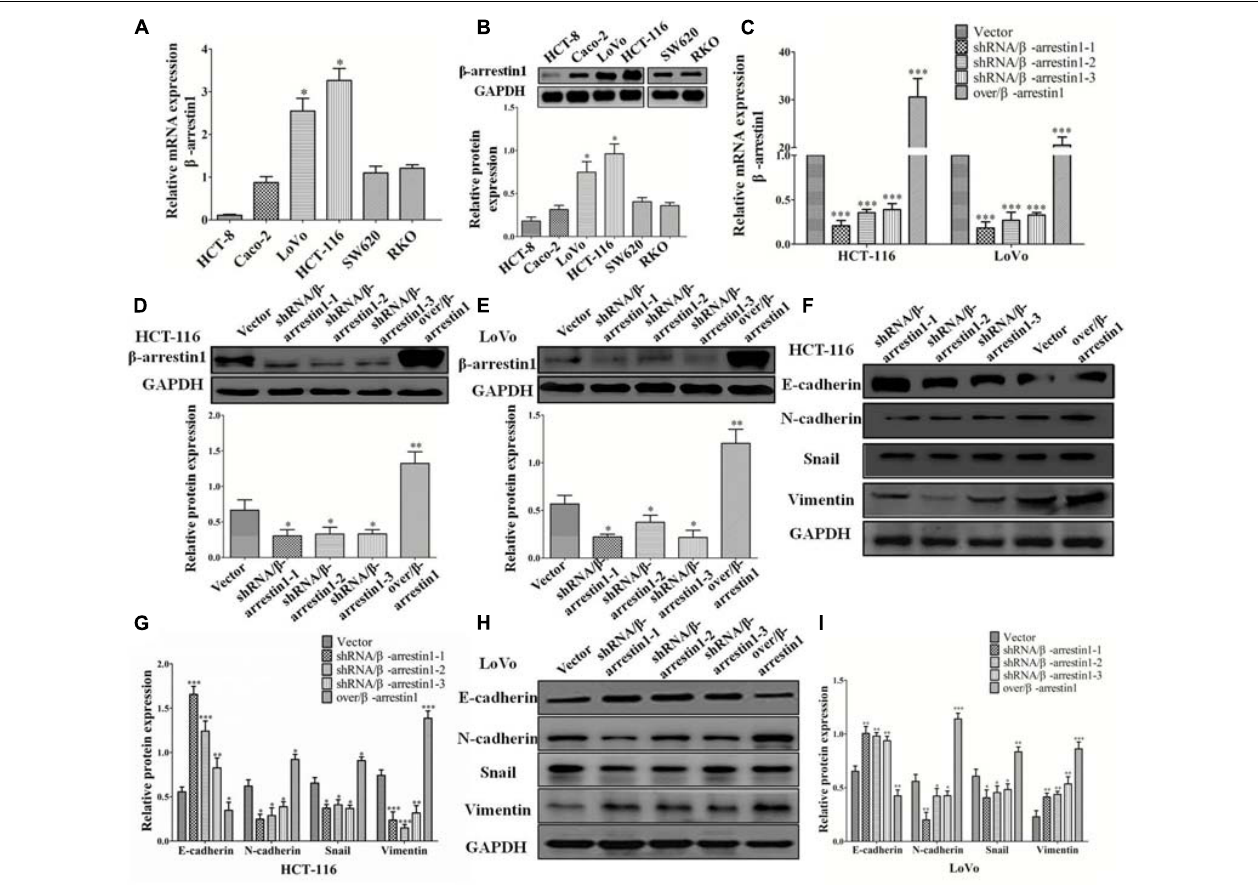
FIGURE 2 | β -arrestin1 regulates the EMT of CRC cells. (A,B) The expression of β -arrestin1 was detected in six CRC cell lines by reverse transcription quantitative PCR. β -arrestin1 had a higher expression level in LoVo and HCT-116 cells, ∗ P < 0.05 vs. the other four established human CRC cell lines HCT-8, Caco-2, SW620 and RKO. (C) The mRNA expression of β -arrestin1 in shRNA/ β -arrestin1 and over/ β -arrestin1 groups was detected by reverse transcription PCR. ∗ P < 0.05; ∗∗ P < 0.01 vs. HCT-116-vector or LoVo-vector cells. (D–E) Western blotting detected the protein expression of β -arrestin1 in shRNA/ β -arrestin1 and over/ β -arrestin1 groups in HCT-116 or LoVo cells. ∗∗∗ P < 0.001 vs. HCT-116-vector or LoVo-vector cells. (F–I) Expression levels of epithelial or mesenchymal markers in HCT-116 or LoVo cells were analyzed by western blotting. ∗ P < 0.05; ∗∗ P < 0.01; ∗∗∗ P < 0.001, vs. HCT-116-vector or LoVo-vector cells. EMT, epithelial-to-mesenchymal transition; CRC, colorectal cancer; shRNA, short hairpin